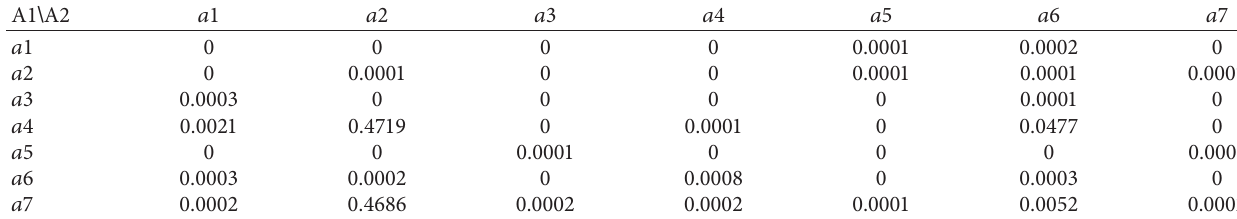
Table 7: Calculated optimal mix strategy of “A”: stage